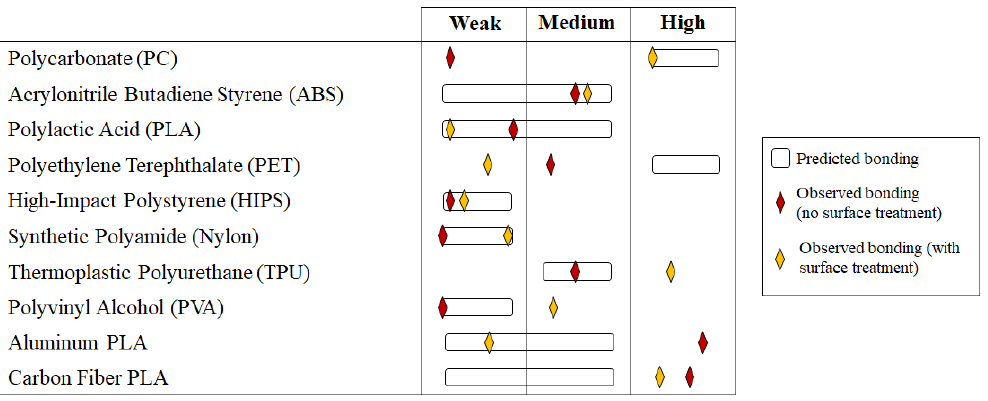
Table 5. Printing test results for CubeGlue ® -treated PC build plate. Figure 20. Observed versus predicted normal bonding strength of tested FDM materials. The effects of the CubeGlue ® on the various materials was significant, as the use of it changed the surface chemistry of the PC plate. It should be noted that all the PC plates coated with the epoxy were washed carefully and checked for surface damage after the printing, of which none was found. A side-by-side comparison of the bonding strength demonstrates the difference, which can be seen in Figure 21a. It is obvious that the CubeGlue ® itself bonded very well with the PC plate and the bond between the glue and the printed material determined the bonding strength. The results for the shear breaking force (Figure 21b) were very similar to those of the normal force, except that PET and TPU was more consistent in bending strength than normal strength. This is most likely an effect of the CubeGlue ® bonding with the materials in a weaker, but more consistent, manner than with the bare plate itself. Details regarding the potential causes and effects of this glue–material bonding will be discussed further in Section A comparison of observed normal adhesion with the predicted bonding ranges from Section 3 can be seen in Figure 20. The untreated PC print bed did well with seven of the 10 materials, with PC, PVA, and nylon refusing to adhere to it well enough to support a print. To ensure that the conditions using a fresh PC plate; the results were identical to the original test. The addition of a thin layer of